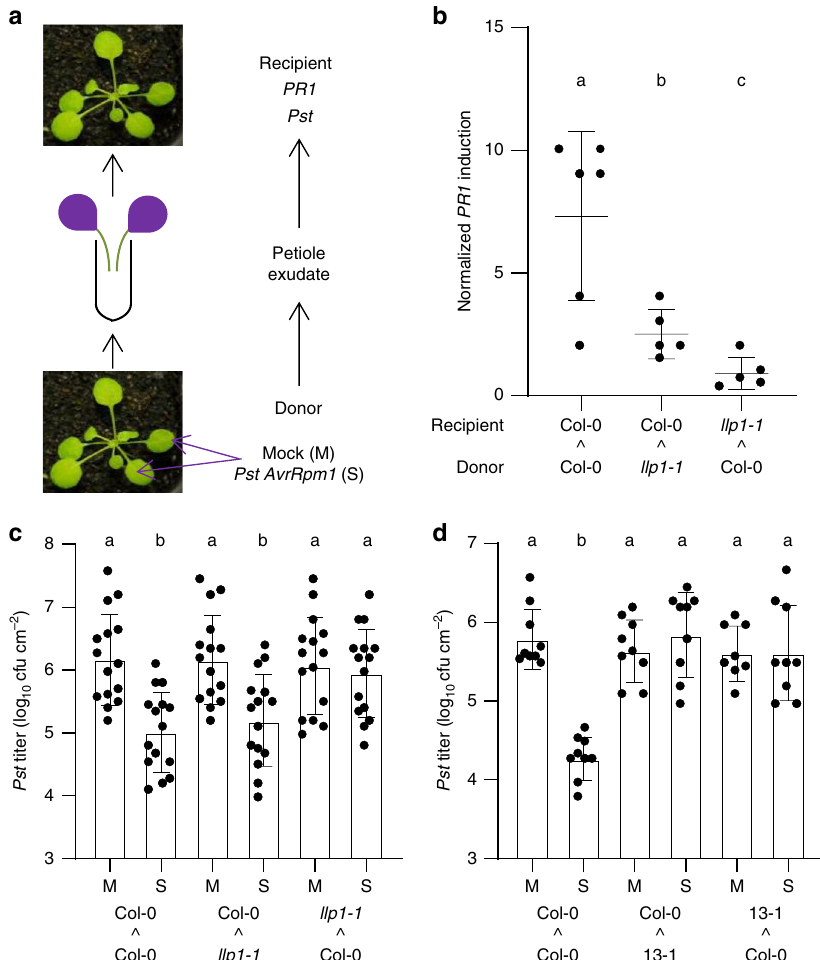
Fig. 1 Legume lectin-like protein 1 (LLP1) is necessary for the recognition of or downstream responses to vascular systemic acquired resistance (SAR) signals. a Setup of a petiole exudate experiment. Leaves of donor plants were inoculated with Pseudomonas syringae pathovar tomato ( Pst ) carrying the effector locus AvrRpm1 (SAR-induced; S) or mock-treated (M). Twenty-four hours later, their petiole exudates were collected and in fi ltrated into the leaves of naive recipient plants. b Pathogenesis-Related 1 ( PR1) transcript accumulation in recipients of petiole exudates from SAR-induced donor plants normalized to that in recipients of petiole exudates from mock-treated donor plants. Donor and recipient genotypes are indicated below the panel. Dots represent data from fi ve to six biologically independent experiments; lines indicate average ± standard deviation. Grubb ’ s outlier test identi fi ed statistically signi fi cant outliers in the data sets llp1-1- to-Col-0 and Col-0-to- llp1-1 ; these outliers were excluded from further analyses to assure normal distribution of the remaining data and are highlighted in gray in the source data fi le associated with this paper. c , d In planta Pst titers at 4 days post-inoculation (dpi) of the leaves of the recipient plants. The treatments of the donor plants are indicated below the bars. The donor and recipient genotypes are indicated below the panels; 13-1 refers to RNAi:LLP1-3 line 13-1 (Supplementary Fig. 1A). Dots indicate individual results from three ( d ) to fi ve ( c ) biologically independent experiments, including three replicates each. Bars represent the average of the indicated results ± standard deviation. Results with a second independent RNAi:LLP1-3 line are presented in Supplementary Fig. 1B. b – d Different letters above bars indicate signi fi cant differences, one-way ANOVA, P <